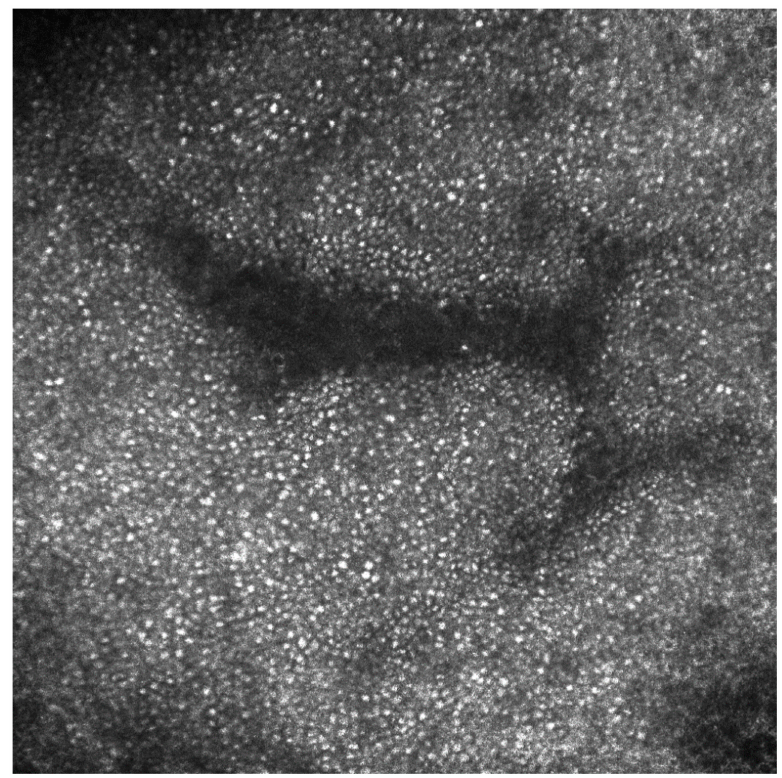
Figure 3. Reflectance confocal microscopy reveals the presence of intracellular hyper-reflective inclusions in most of the epithelial cells of the cornea related to deposition and accumulation of